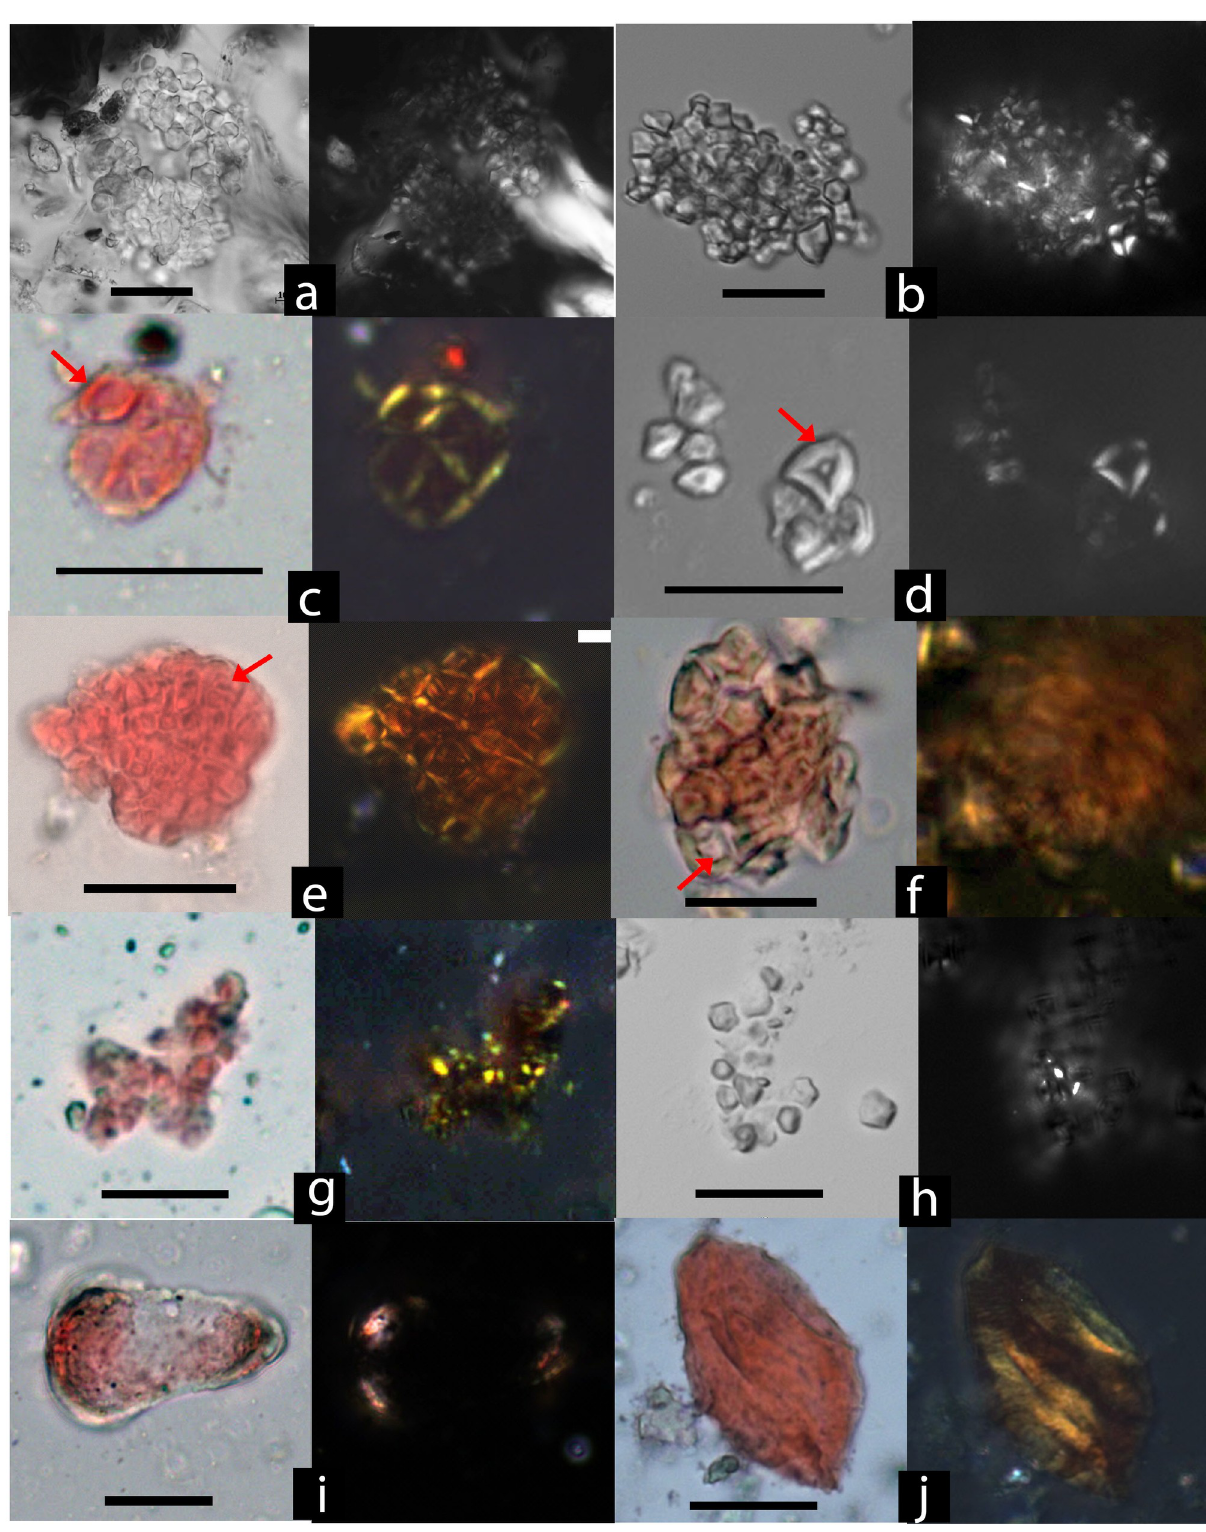
Fig 4. Starch granules from Qiaotou pots compared with rice brewing experiment samples. Qiaotou samples: (a) Qiaotou Type I starch (rice), compared with (b); (c) and (e) Compound rice starch granules showing central pitting (pointed by red arrows) and gelatinization (starch damage type